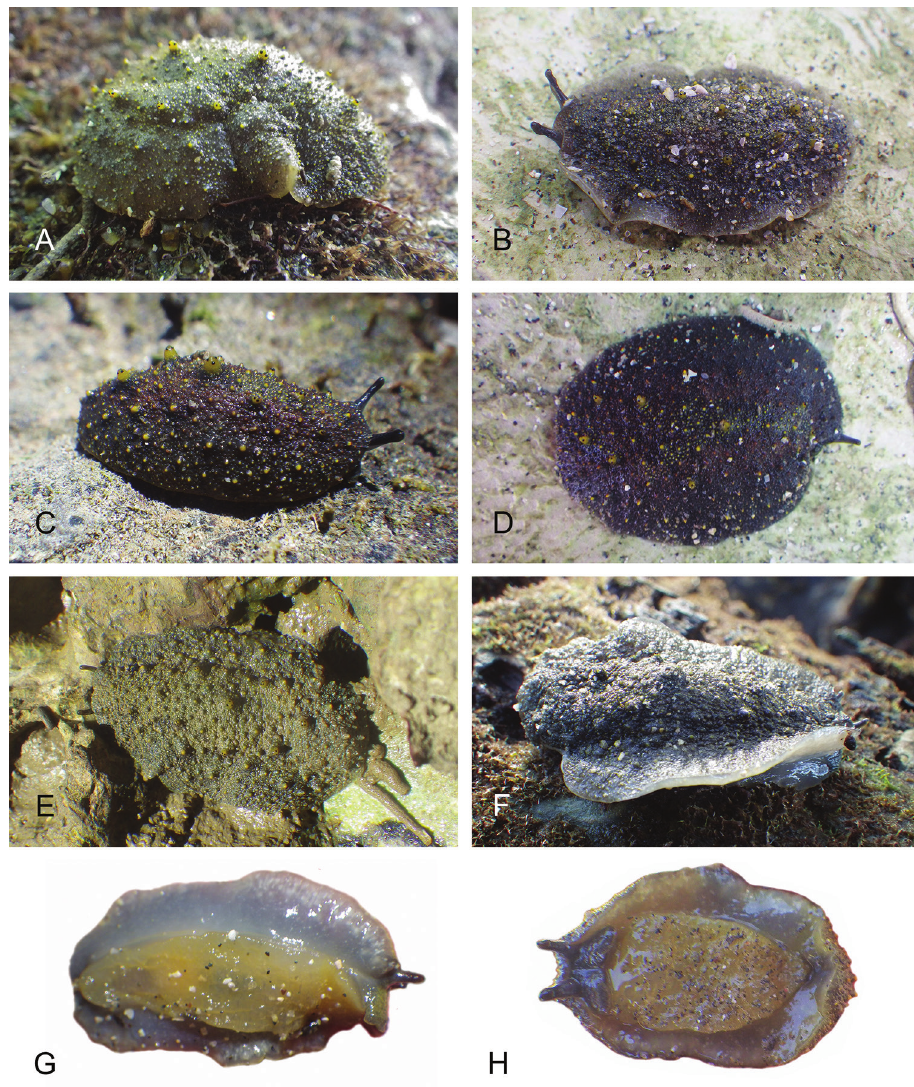
Figure 60. Live specimens, Wallaconchis melanesiensis , Indonesia. A Dorsal view, 25 mm long [5131], Halmahera (UMIZ 00069) B Dorsal view, 27 mm long [5133], Halmahera (UMIZ 00069) C Holotype, dorsal view, 15 mm long [5065], Halmahera (UMIZ 00065) D Dorsal view, 23 mm long [5132], Halma- hera (UMIZ 00069) E Dorsal view, 27 mm long [2963], Lombok (UMIZ 00070) F Dorsal view, 43 mm long [2735], Ambon (UMIZ 00068) G Ventral view, same as B H Ventral view, same as C.